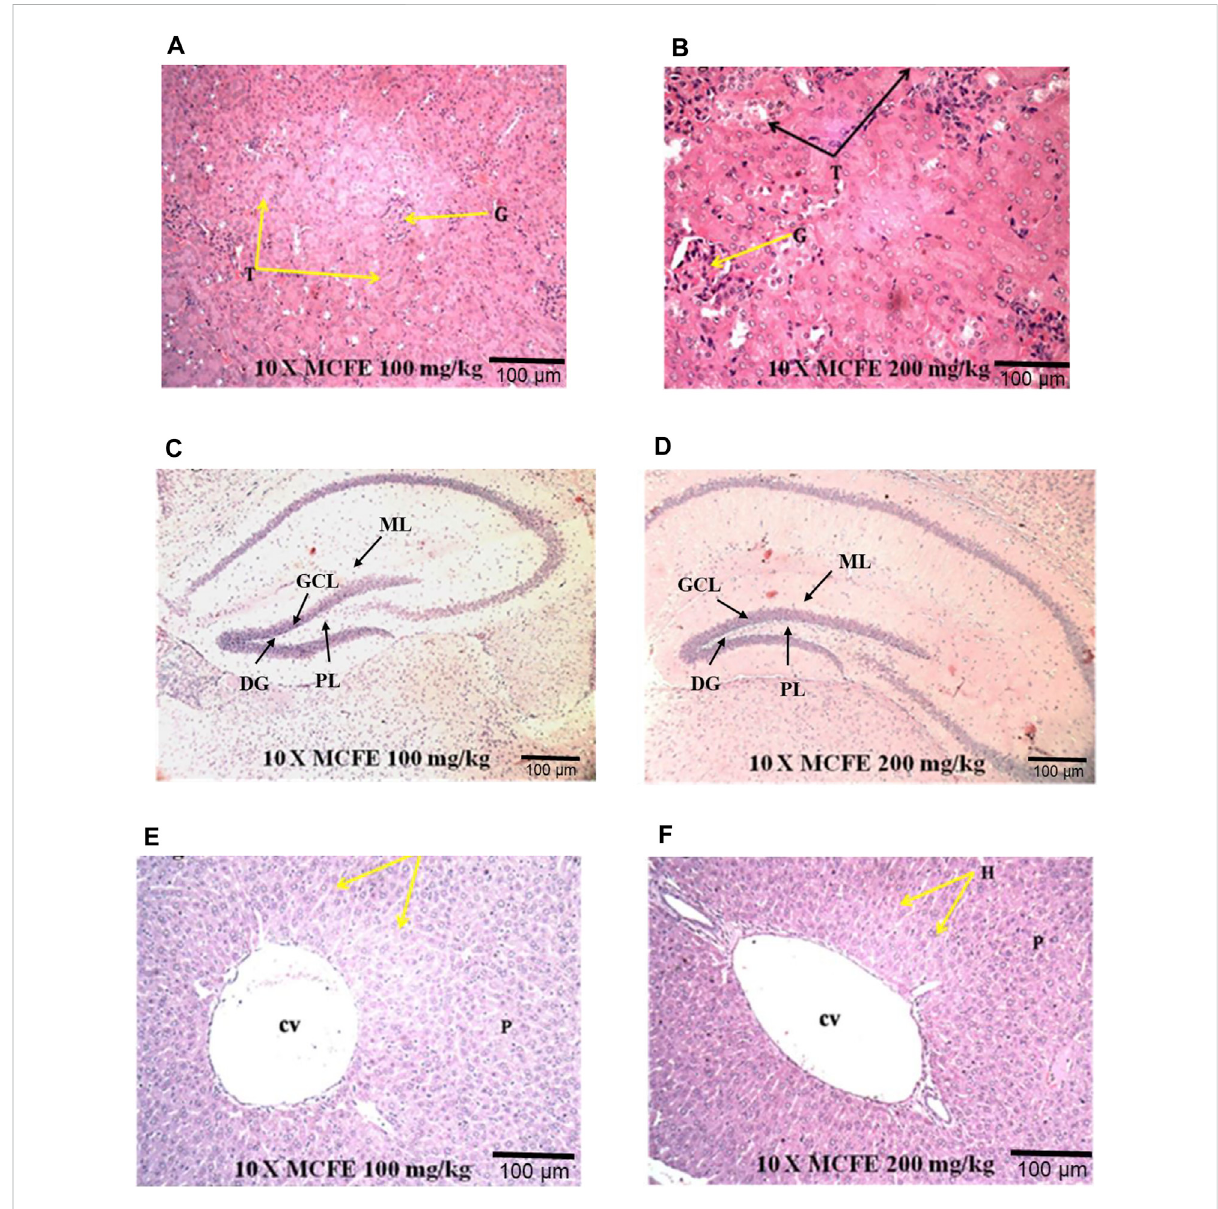
FIGURE 6 Photomicrographs at 10× magni fi cation of haematoxylin and eosin (H&E) stained kidney (A) and (B) ; brain (C) and (D) ; liver (E) and (F) , when MCFE is administered at different doses in mice model. *(G) Glomerulus, (T) Tubules; (DG) Dentate gyrus, (GCL) Granule cell layer, (ML) Molecular layer, (PL) Polymorphic layer; Central vein (cv), Parenchyma